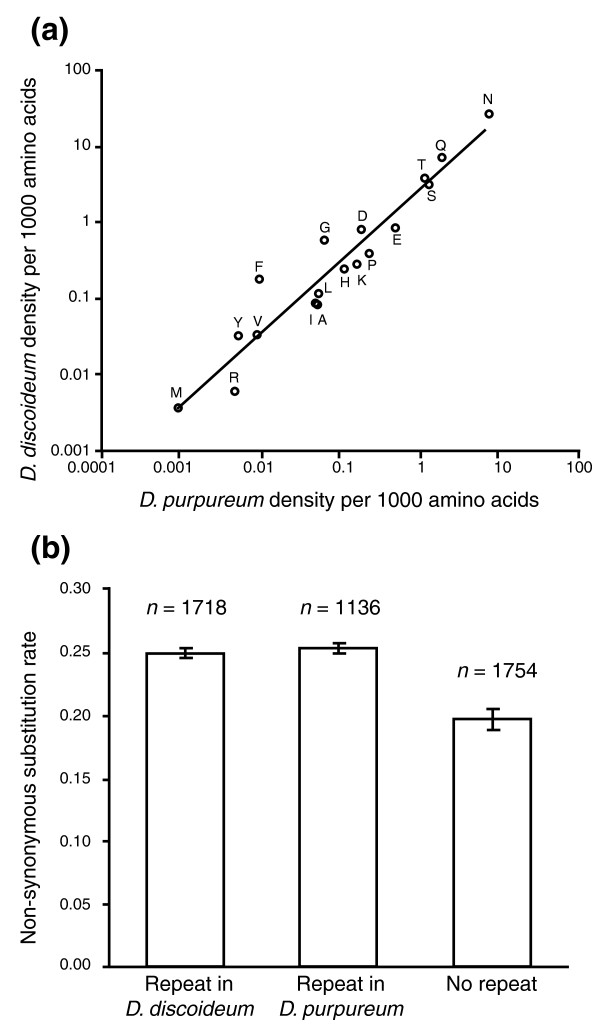
Densities of different homopolymer amino acid repeats in D. purpureum and D. discoideum. (a) The density of each kind of amino acid repeat was calculated by summing the lengths of non-random repeats of that amino acid (Table S1 in Additional file 1) over protein sequences of all genes from D. purpureum and D. discoideum, dividing by the total length of coding sequence, and multiplying by 1,000. Letters indicate which amino acid each point represents. The Pearson's correlation coefficient between them is 0.997, P < 0.001. (b) Mean (± standard error) non-synonymous substitution rates (dNs) of genes with and without amino acid repeats. The non-synonymous substitution rates were calculated between orthologs (excluding repeat sequences) of D. purpureum and D. discoideum. Orthologs without amino acid repeats have significantly lower dN than orthologs with repeats in either D. discoideum and D. purpureum (Students t-test, both tests P < 0.0001). Error bars show standard errors of the means.